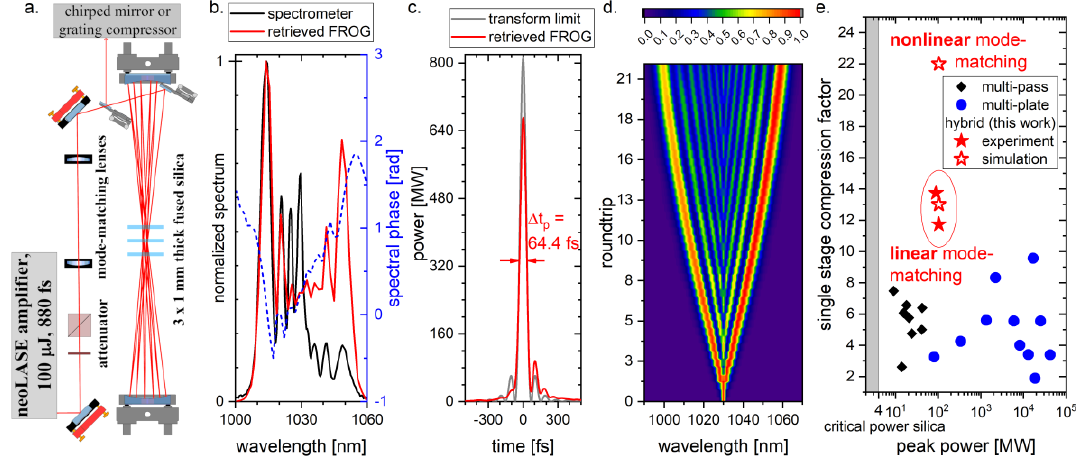
Fig. 1 a. Experimental setup. b. Retrieved FROG spectrum in comparison to grating spectrometer spectrum after 23 roundtrips in the 380 mm cavity. c. Corresponding retrieved pulse in comparison to the Fourier transformed spectrum. d . Simulation of spectral broadening with 6 plates in the MPC and nonlinear mode-matching. e. Reported single stage compression factors of bulk multi-pass and multi-plate experiments in comparison to the results presented here. Encircled are the experimental 75 fs and 65 fs compression results (solid red stars) and the benchmarking simulation (hollow star). The hollow star at the top predicts 40 fs pulses for 6 plates if mode-matching accounts for